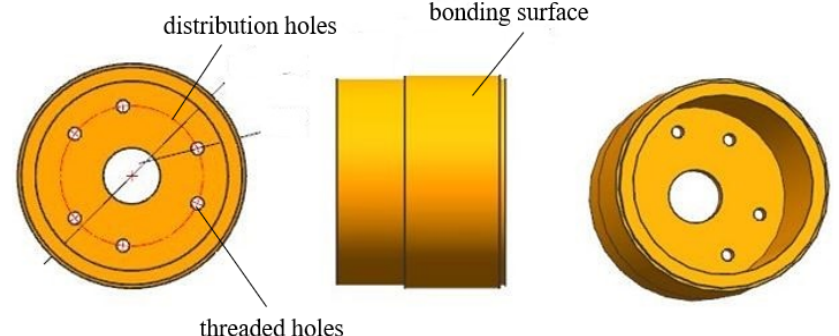
Figure 3. Rigid connector.